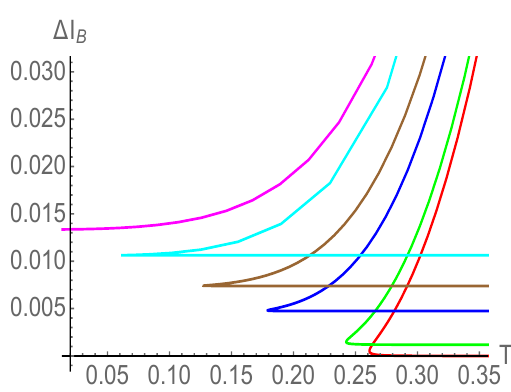
Figure 22 . (cid:1) I B as a function of T for various values (cid:22) . Here ‘ = 0 : 2 and x = 0 : 1 are used and red, green, blue, brown, cyan and magenta curves correspond to (cid:22) = 0, 0 : 2, 0 : 4, 0 : 5, 0 : 6 and 0 : 673 respectively. In units